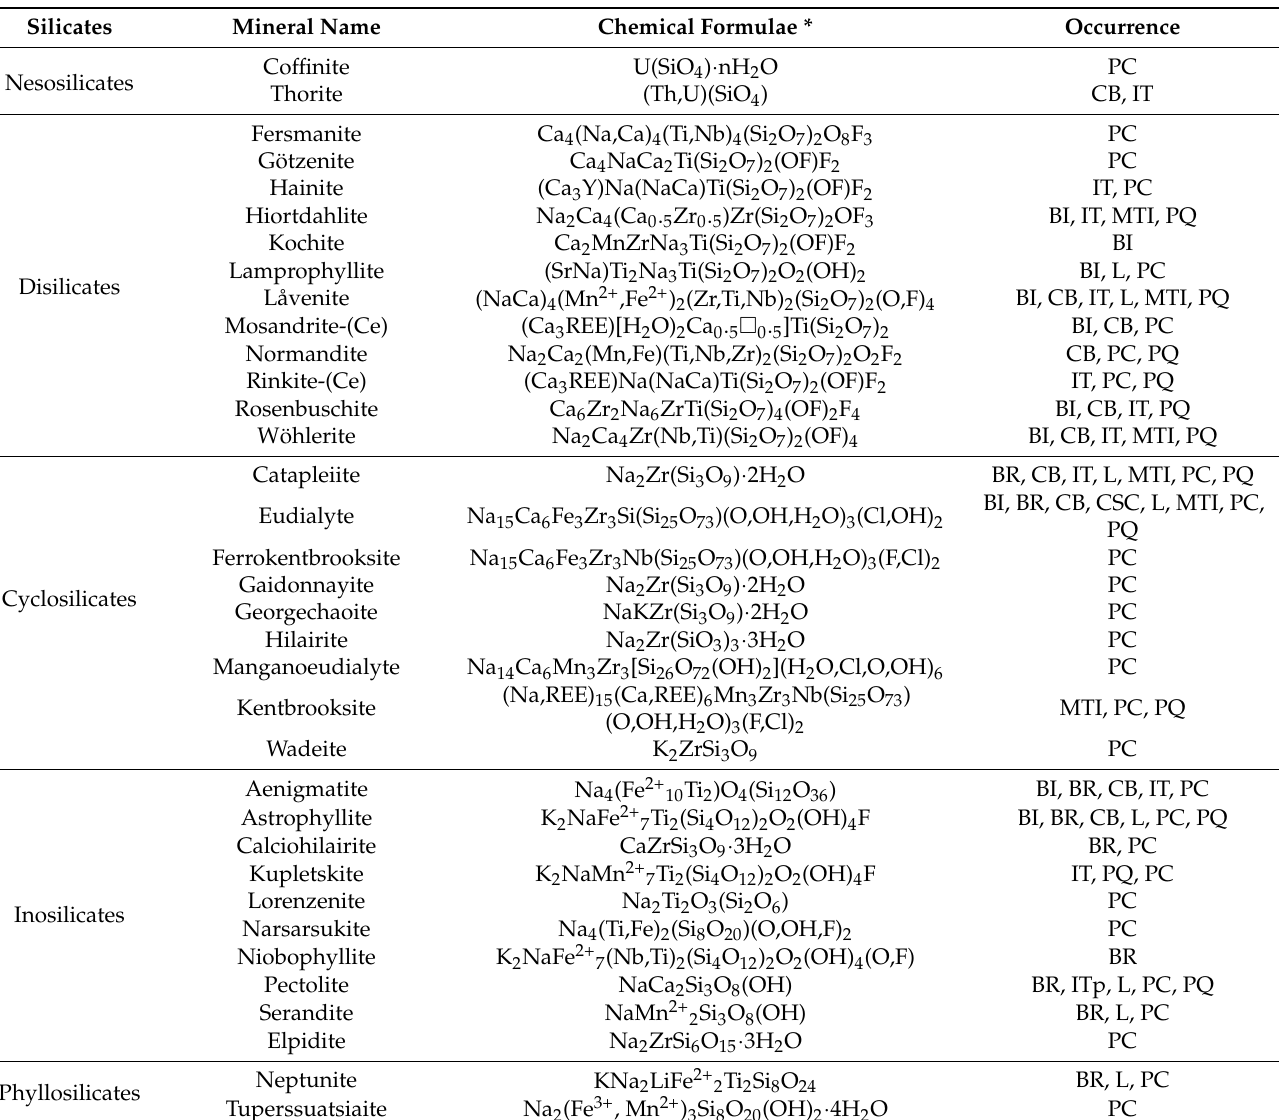
Table 3. HFSE accessory mineralogy of agpaitic